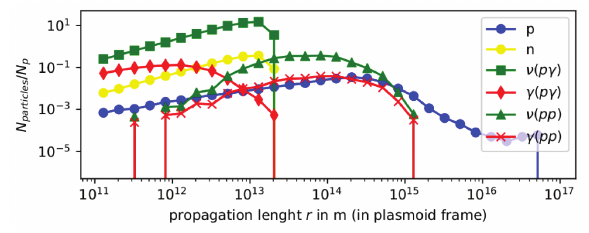
Figure 5. Percentage of escaping particles produced in 10 8 GeV proton flare as a function of the distance to the central super- massive black hole. Note that it is possible to distinguish the secondary production from di ff erent interactions. Credits: L.